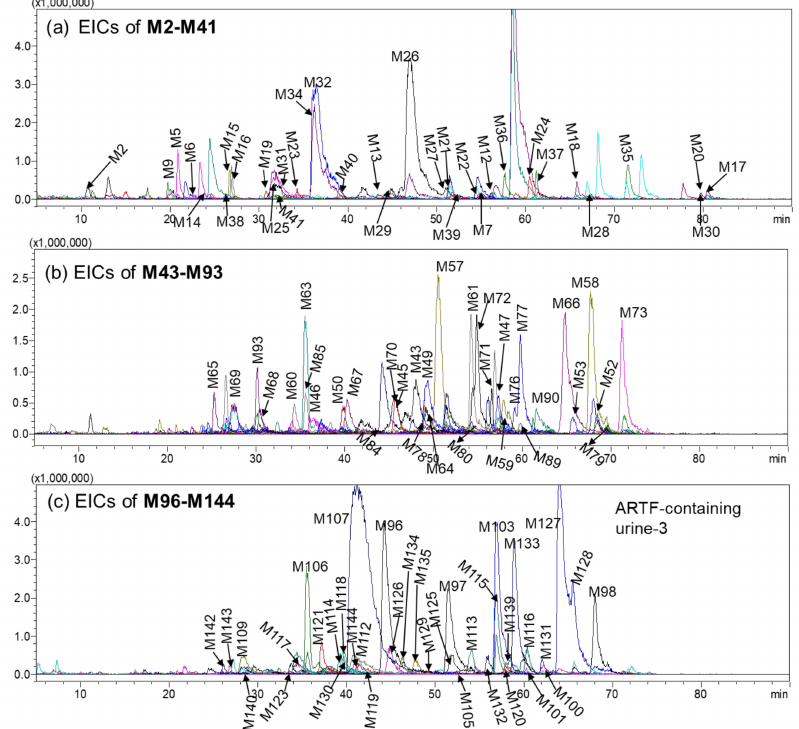
Figure 2. The EICs of 106 metabolites in rat urine after administration of ARTF. ( a ) EICs of M2 – M41 ; ( b ) EICs of M43 – M93 ; ( c ) EICs of M96 – M144